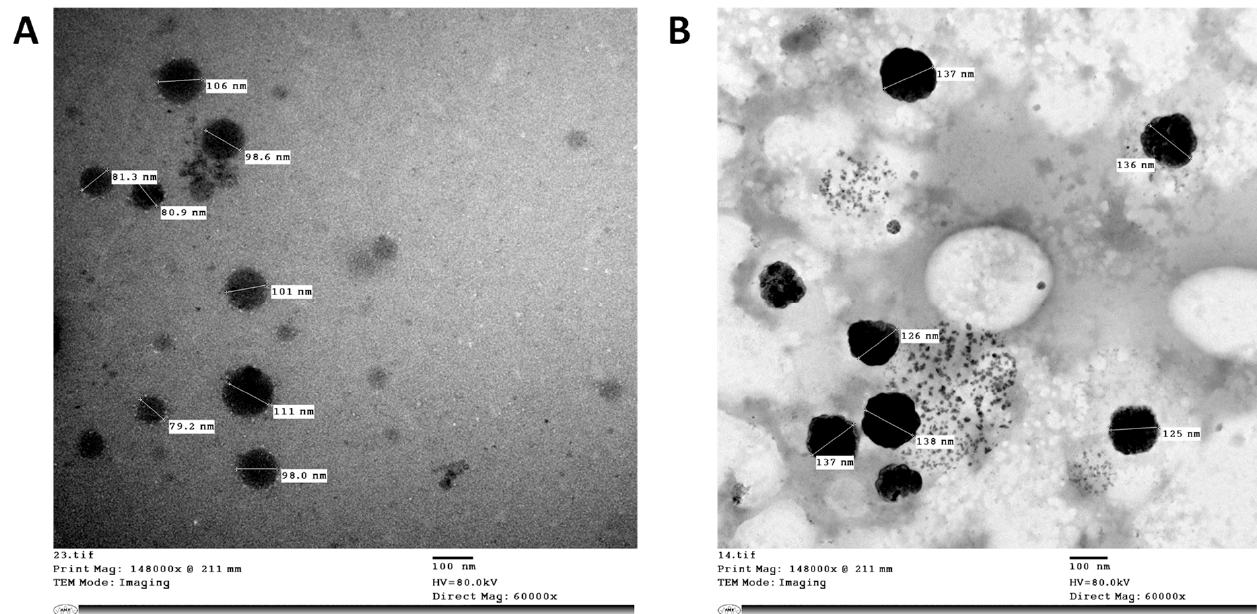
Figure 1. TEM images of rhamnolipid nano-micelles in ( A ) solution and ( B ) gel prepared at a concentration 10 mg/mL of rhamnolipids.